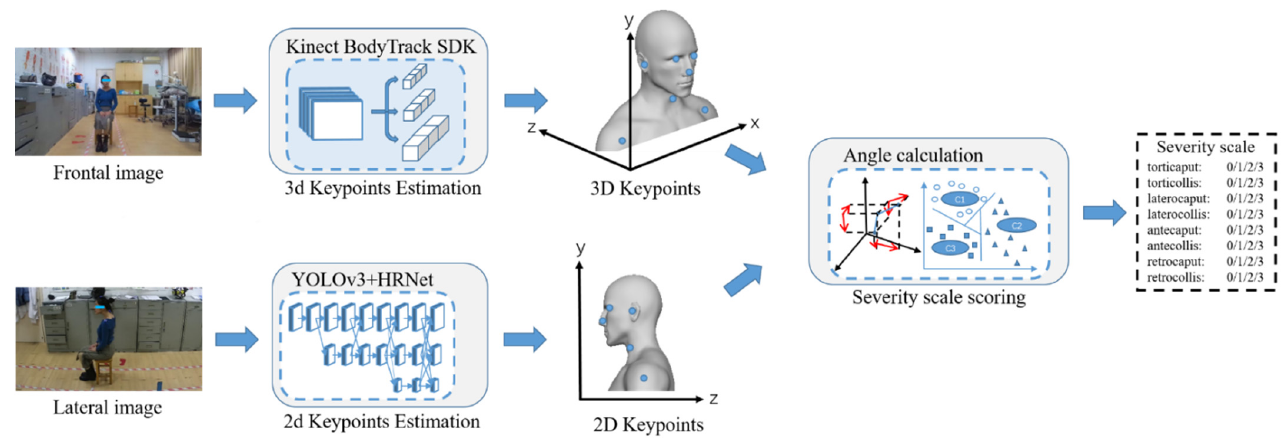
Figure 3. Devices Diagram for the multi-view vision based method.